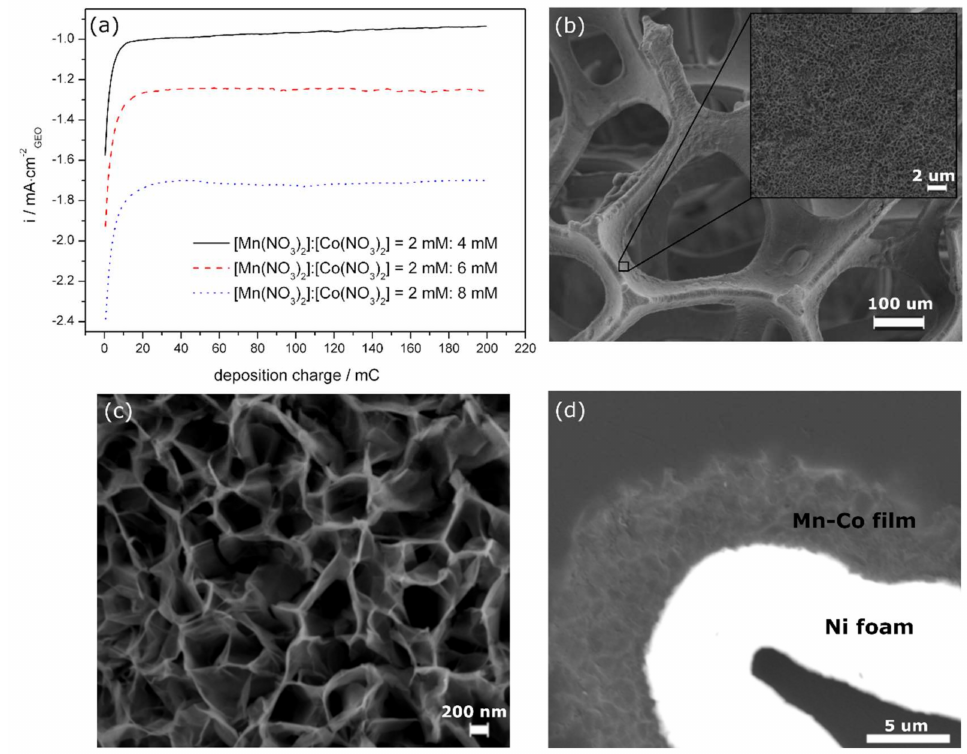
Figure 1. ( a ) Synthesis graphs recorded during the electrochemical synthesis of Mn / Co oxide / hydroxides at − 1.1 V vs. Ag / AgCl in an aqueous solution of di ff erently concentrated Mn(NO 3 ) 2 · 4H 2 O and Co(NO 3 ) 2 · 6H 2 O with the deposition time limited by a charge of 200 mC; ( b – d ) SEM images of Mn-Co film deposited on nickel foam in a solution of Mn / Co (2 mM / 8 mM) for 200 mC with di ff erent magnifications ( b , c —surfaces, d —polished